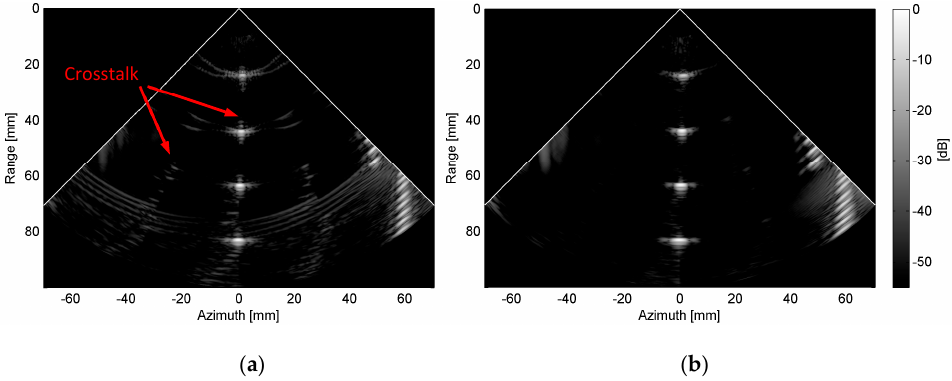
Figure 2. Reconstructed images of a wire phantom in water acquired using a 4-MLT (Multi-line transmit) imaging scheme ( a ) without apodization, the ghost-like crosstalk artifacts are presented; and ( b ) with a Tukey ( α = 0.5)-Tukey ( α = 0.5) apodization on transmit and receive, the crosstalk artifacts are suppressed significantly.